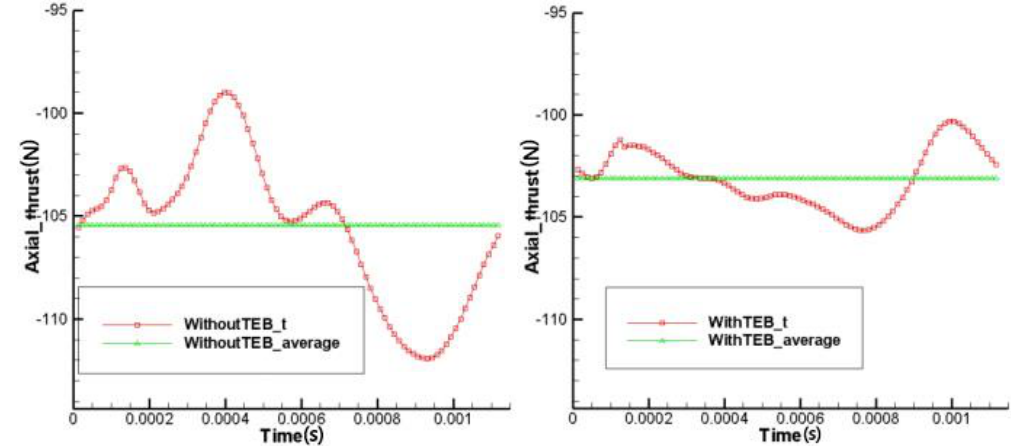
Figure 5. Axial thrust with and without nonuniform trailing edge blowing (NTEB).